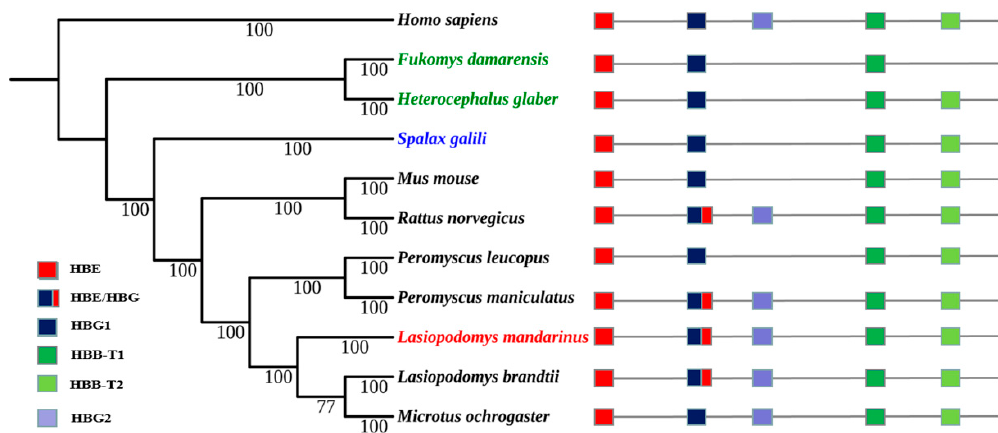
Figure 3. Bayesian phylogenetic tree of rodent species and the genomic structures of their β -globin genes. Numerals indicate Bayesian posterior probability values; colored text indicates subterranean rodent species.